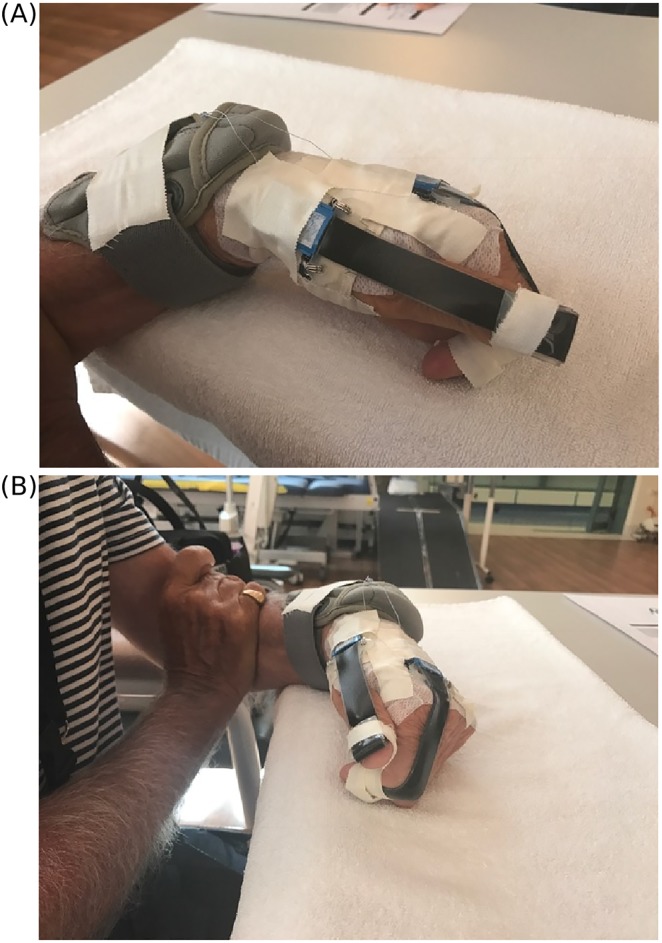
Stretch sensors worn on the left hand of a subject with stroke, showing the set-up in greater detail (A) at the thumb and (B) at the index finger.The thumb sensor was applied over the metacarpophalangeal and interphalangeal joints, and the index finger sensor was applied over the metacarpophalangeal and proximal interphalangeal joints. Each sensor was connected by cables to a data transmission system and battery in the pouch strapped below the wrist. Data were transmitted to an application on a smart phone carried on a lanyard or in the subject’s pocket (not shown).